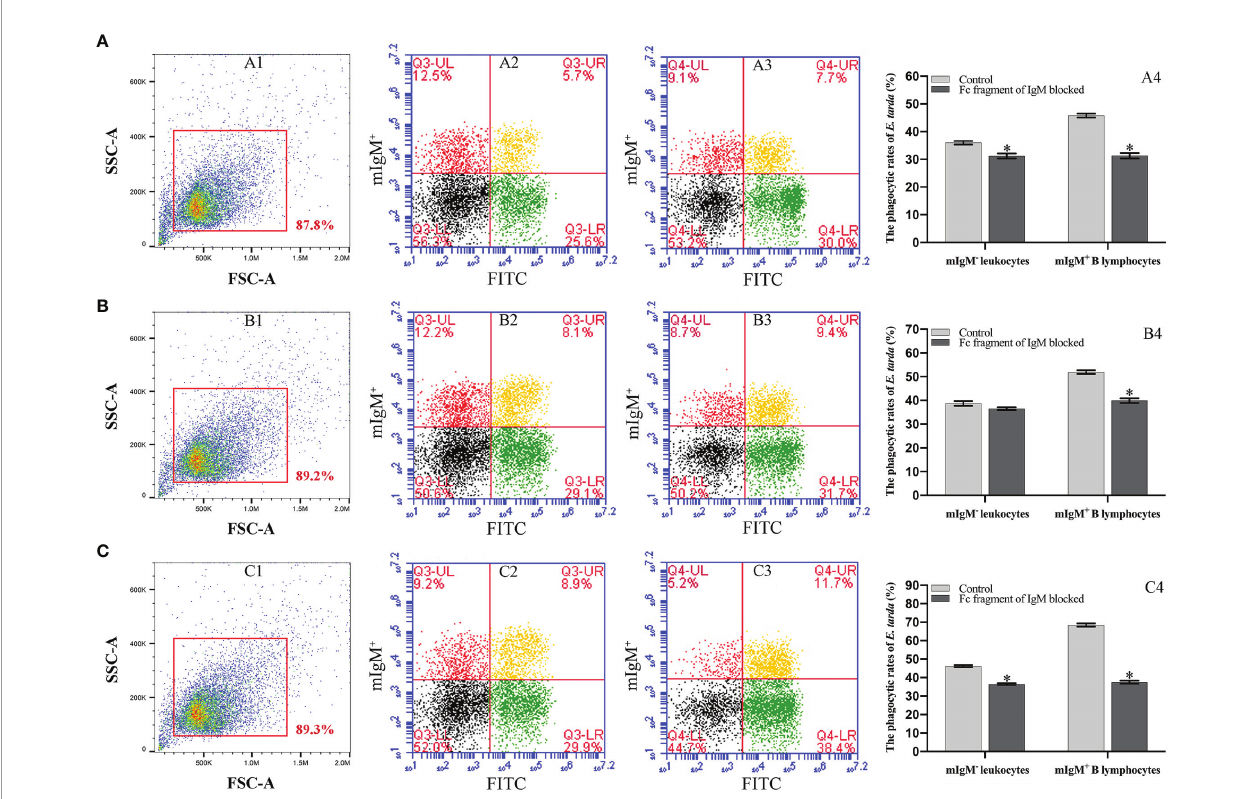
FIGURE 3 | Analysis of phagocytosis rates of fl ounder mIgM + B lymphocytes after opsonization of E . tarda and Fc blocking by fl ow cytometry. (A – C) Phagocytosis rates of mIgM + B lymphocytes after incubation with E . tarda for 1 (A) , 2 (B) or 3 h (C) . 1: FSC/SSC plots of PBLs. Fluorescence scatter plots of PBLs incubated with Fc blocking (2) and unblocked (3) E . tarda . 4: Phagocytosis rates of mIgM + B lymphocytes and mIgM - leukocytes summarized from the fl uorescence scatter plots. Error bars indicate the standard deviation of the three biological replicates. The asterisks on the bars represent the statistical difference of the phagocytosis rates compared to the unblocked group ( p <